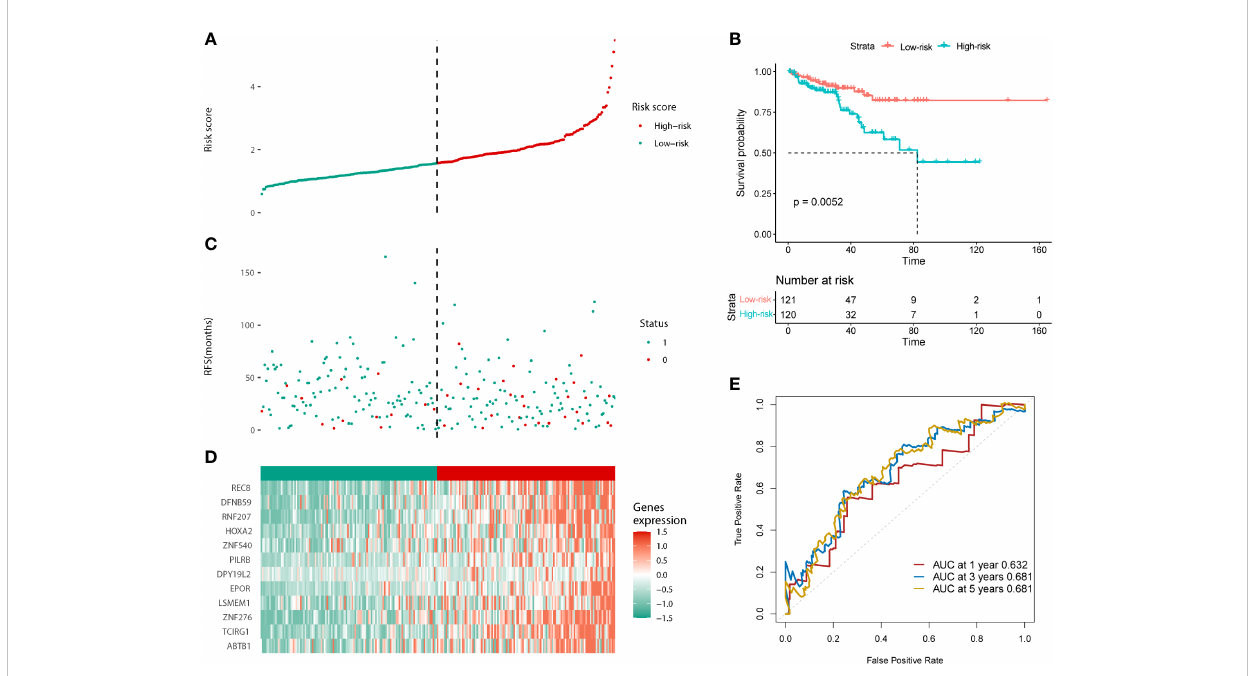
FIGURE 4 Validation of the prognostic model in the test cohort. (A) Distribution of the risk scores. (B) The KM analysis of PFS in the high and low-risk groups. (C) Survival status. (D) Expression of the 12 predictive genes. (E) ROC analysis to evaluate the predictive ef fi